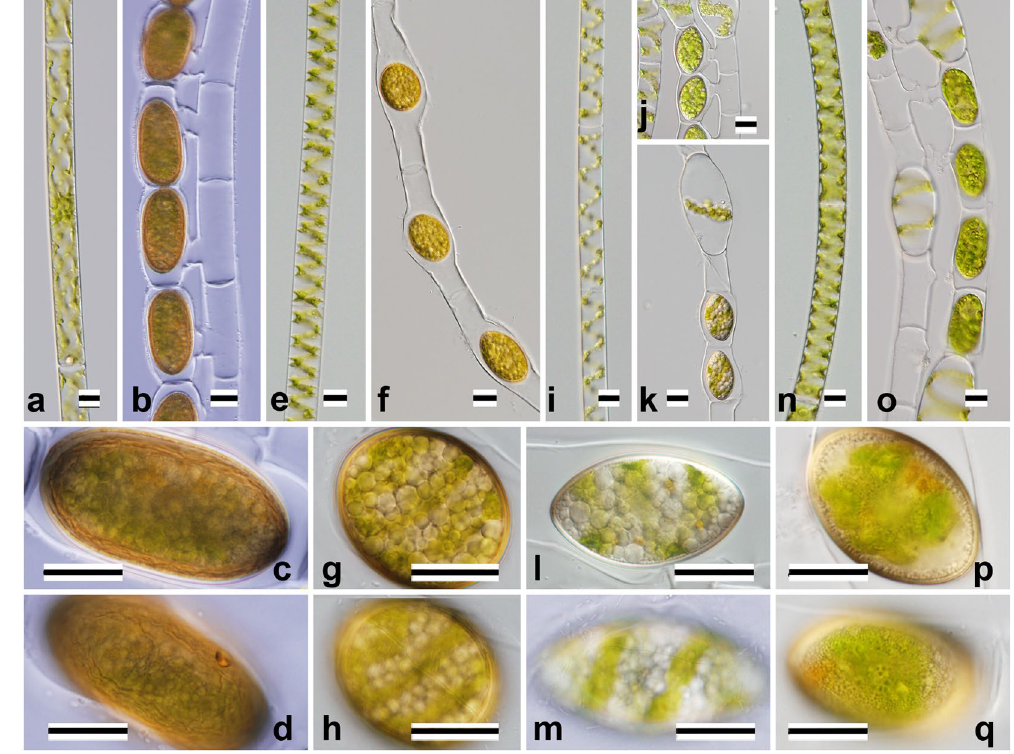
Figure 2. Nomarski interference micrographs of four species of Spirogyra belonging to Clades III–V (Fig. 5a, Table 1). Scale bars = 20 μ m. ( a – d ) S . chungkingensis Uki1 (JPS001). ( e – h ) S . mirabilis shi0305 (JPS010). ( i – m ) S . chenii chiA307 (JPS011). ( n – q ) S . varians chi0102 (JPS015). ( a,e , i , n ) Vegetative cells. ( b , f , j , o ) Formation of zygospores or aplanospores. ( c , g , l , p ) Optical section of zygospore or aplanospores. ( d , h , m , q ) Surface view of zygospore or